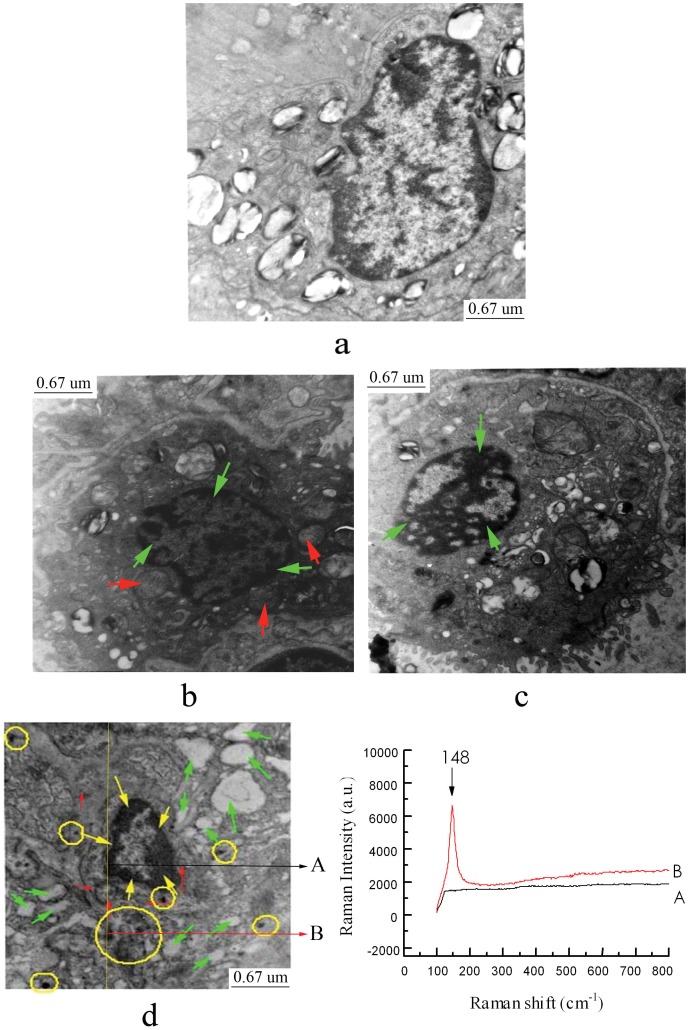
Ultrastructure of pneumonocyte in female mice lung caused by nasal administration of nano-TiO2 for 90 consecutive days.(a) Control: chromatin is well distributed, normal lamellar bodies; (b) 2.5 mg/kg BW nano-TiO2 indicates a significant shrinkage and chromatin marginalization of the nucleus (yellow arrows), mitochondria swelling(red arrows); (c) 5 mg/kg BW nano-TiO2 indicates a significant nucleus pyknosis (green arrows); (d) 10 mg/kg BW nano-TiO2 indicate a significant nucleus pyknosis (yellow arrows), mitochondria swelling(red arrows) as well as evacuation of lamellar bodies (green arrows), circles show black deposition. Arrow A spot is a representative cell that not engulfed the nano-TiO2, while arrow B spot denotes a representative cell that loaded with nano-TiO2. (c) The right panels show the corresponding Raman spectra identifying the specific peak at about 148 cm−1.